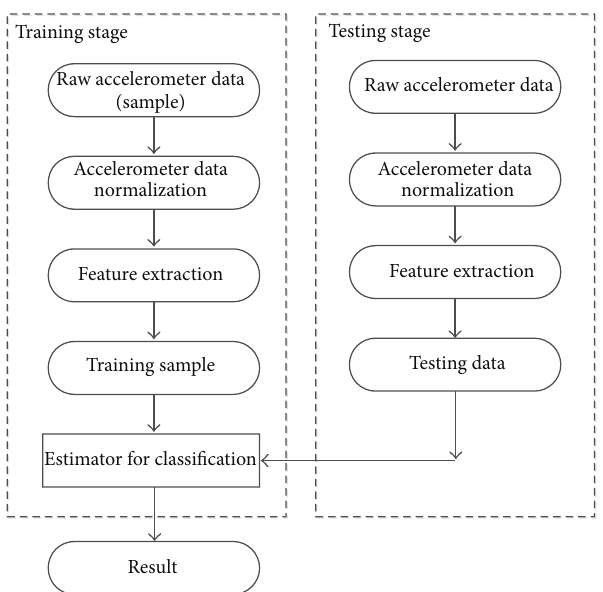
Figure 4: Activity estimator working